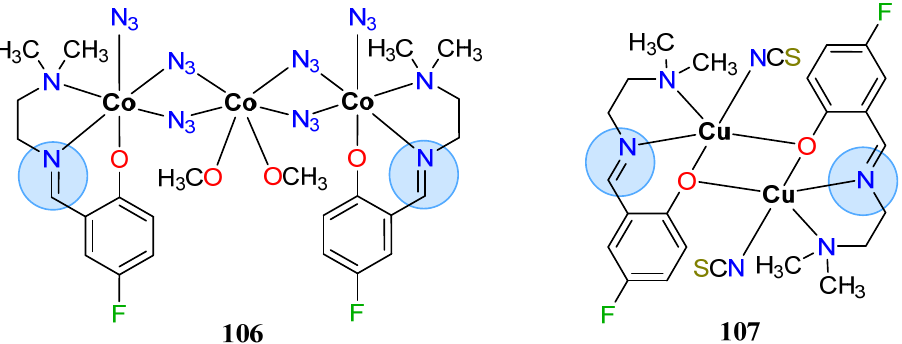
Figure 55. Polynuclear Co(III) and Cu(II) complexes derived from similar tridentate Schiff bases with antimicrobial activity.